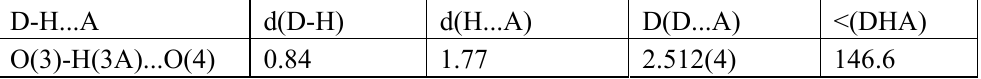
Table 3 . Hydrogen bonds for 4-hydroxy-3-methoxycarbonyl coumarin [Å and